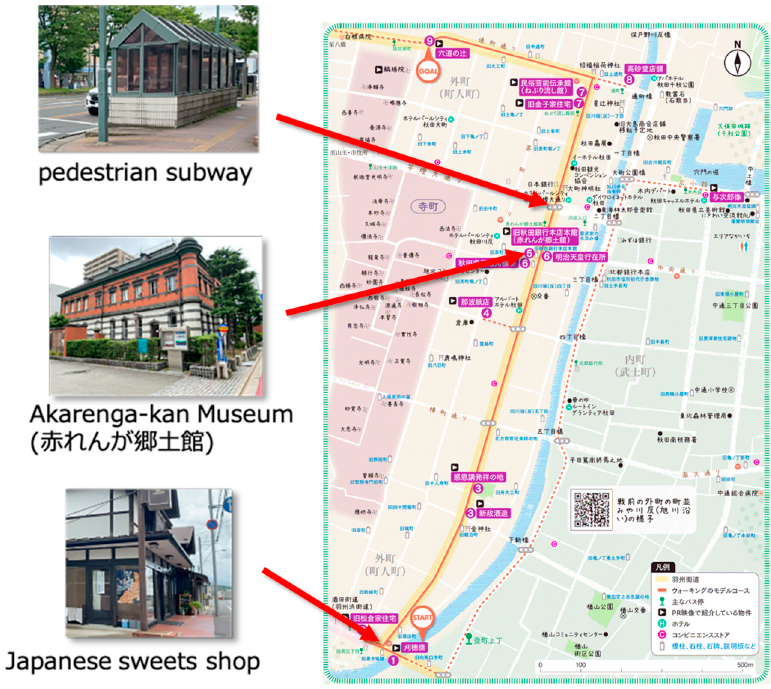
Figure 20. Locations of the points of interest (POIs) that appears in this paper.